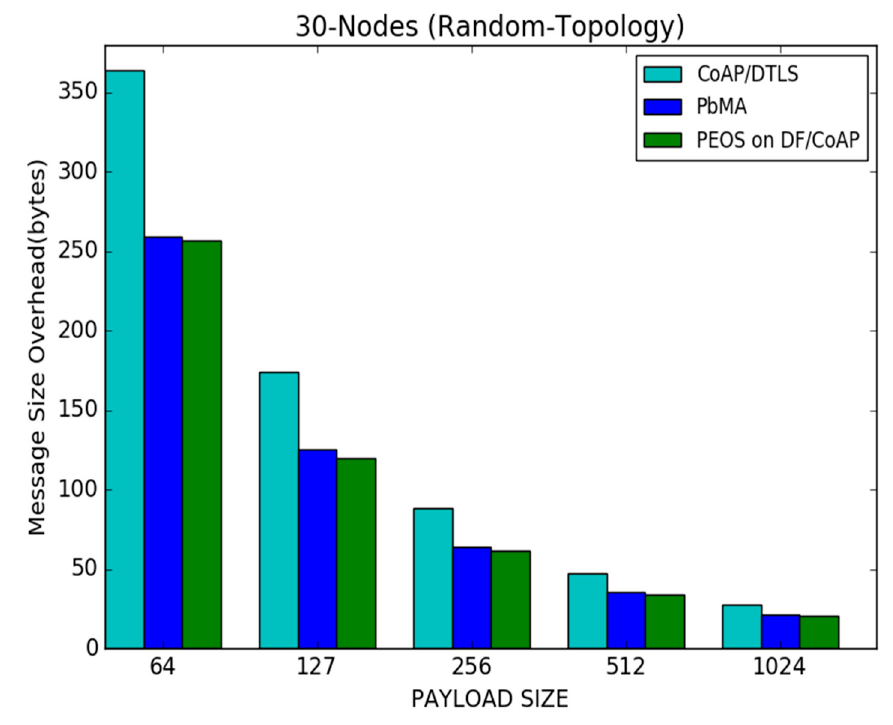
Figure 10. Payload size vs. message size overhead for 30 node topology.